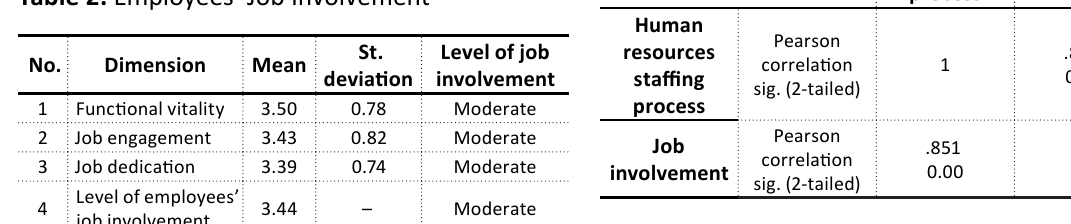
Table 2. Employees’ Job Involvement